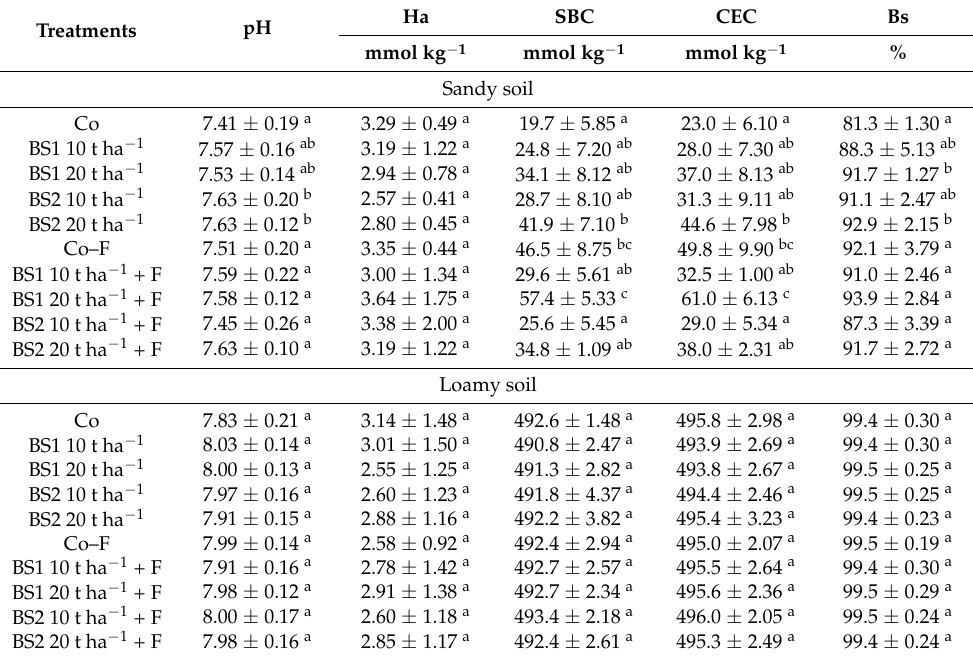
Table 3. Parameters of the soil sorption complex (mean ± standard deviation for 2018–2020).